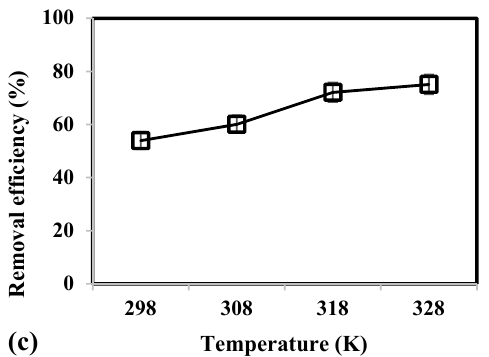
Figure 2. Effect of ( a ) adsorbent mass, ( b ) contact time, and ( c ) temperature on the removal efficiency of As(V) from groundwater using CCB.